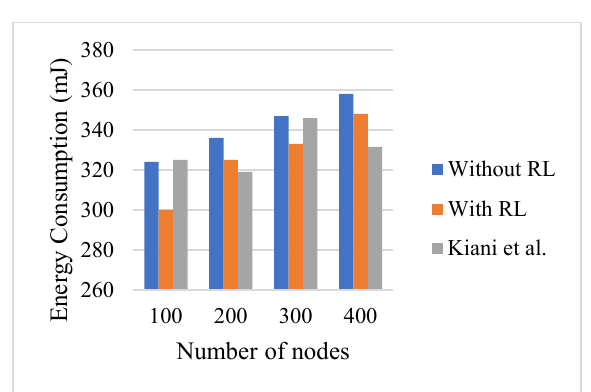
Figure 17. Energy